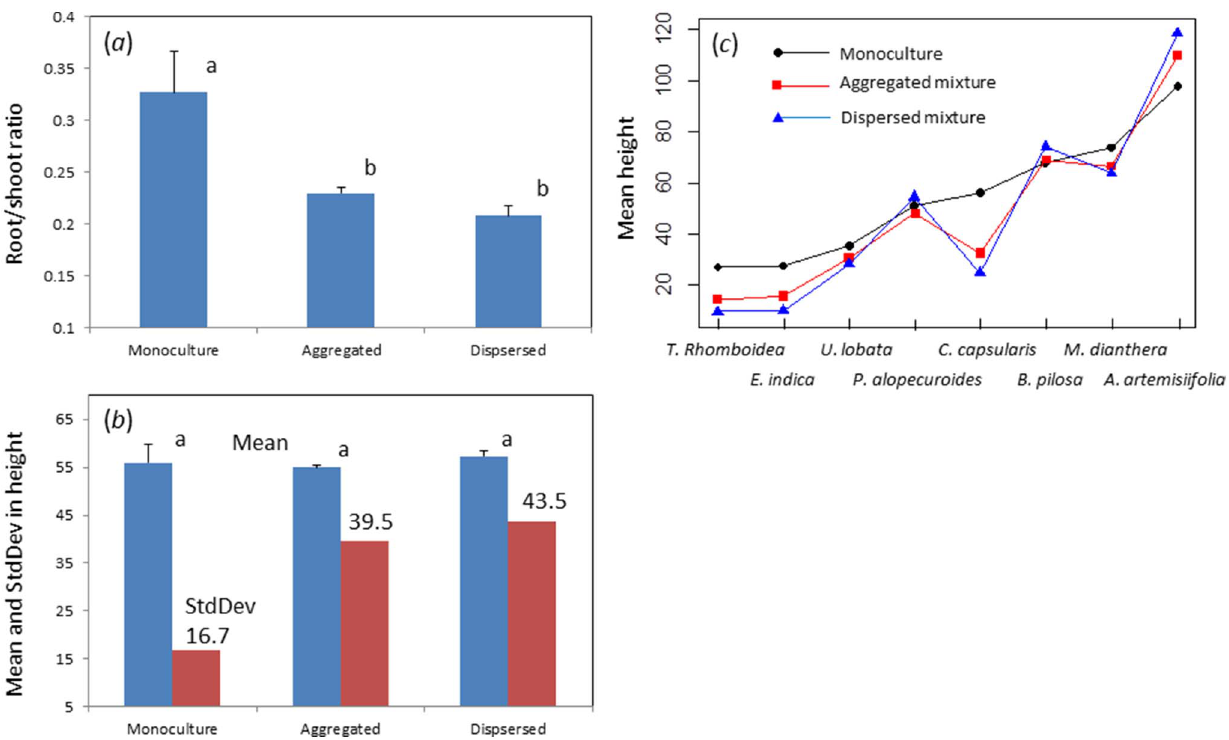
Figure 4. Biomass allocation and plant height variation for experiment I. ( a ) The mean root/shoot ratio varied with heterospecific interactions from monocultures, aggregated to dispersed mixture plots. ( b ) The within-plot mean (left bars) and standard deviation (right bars) in plant height (in cm, calculated over all grids in each plot) versus heterospecific interactions. ( c ) The average height for each of the eight species varied from monocultures, aggregated mixtures to dispersed mixtures. Data bars for the root/shoot ratio in ( a ) and the mean height in ( b ) are mean + 1 standard error. Bars with different letters above are significantly different at P =0.05. The values for the standard deviation for height are shown in ( b ).